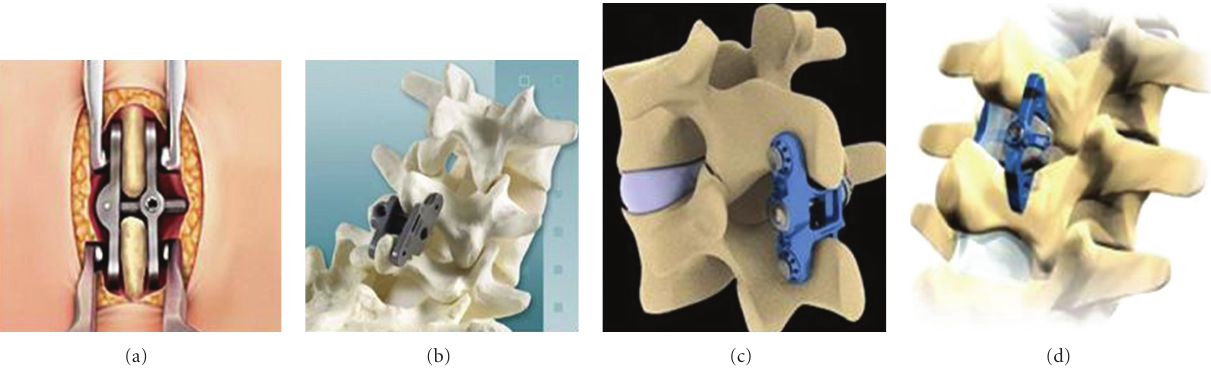
Figure 5: Interspinous fusion devices. (a) CD Horizon spire (Medtronic, Memphis, TN, USA), (b) Aspen (Lanx, Inc., Broomfield, CO, USA), (c) Prima LOK (OsteoMed, Addison, TX, USA), and (d) Axle (X-Spine, Miamisburg, OH, USA) are currently being studied (website).